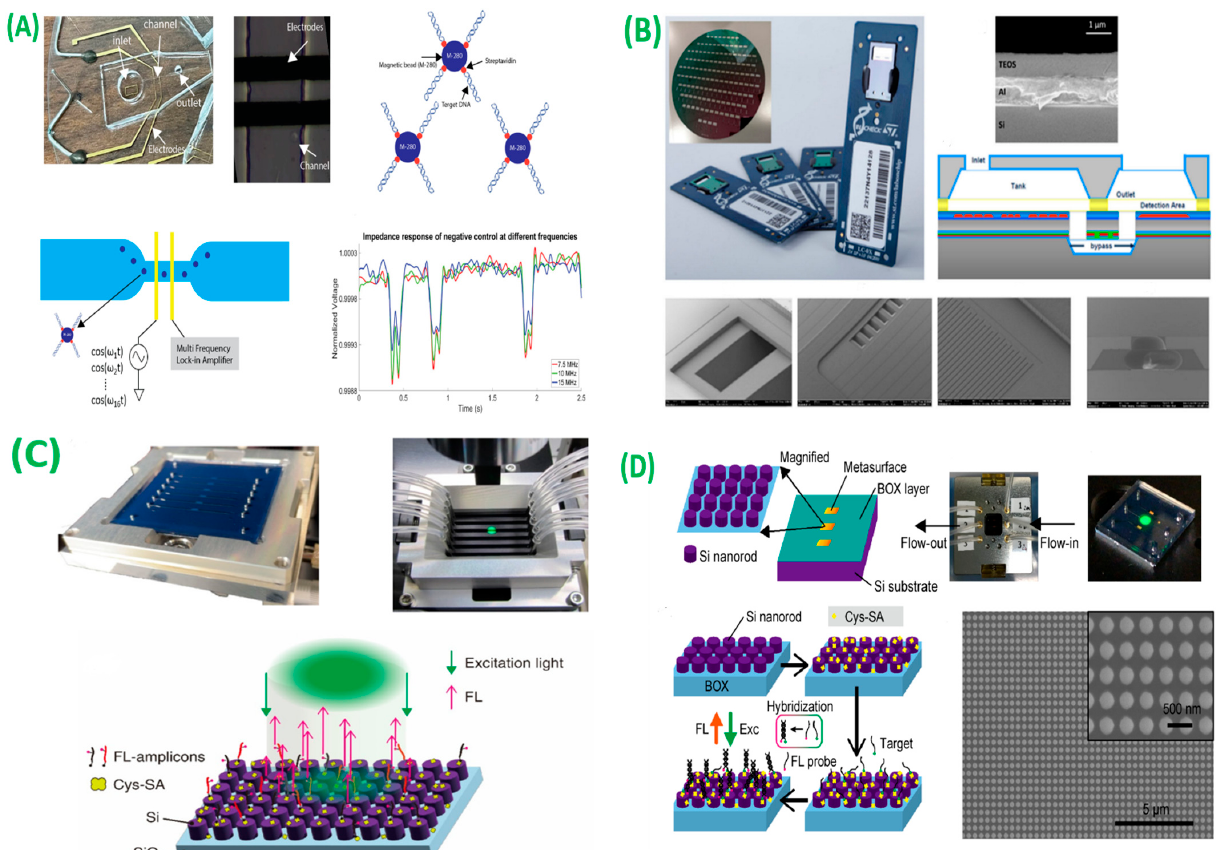
Figure 5. ( A ) Overview of the process and microscopic cross section of channel and electrodes [116] ( B ) Schematic of the LoC developed by STMicroelectronics [117] ( C ) Schematic of meta surface biosensors [118] ( D ) Schematic of dielectric meta surface structure and the whole view of meta surface substrate [119].